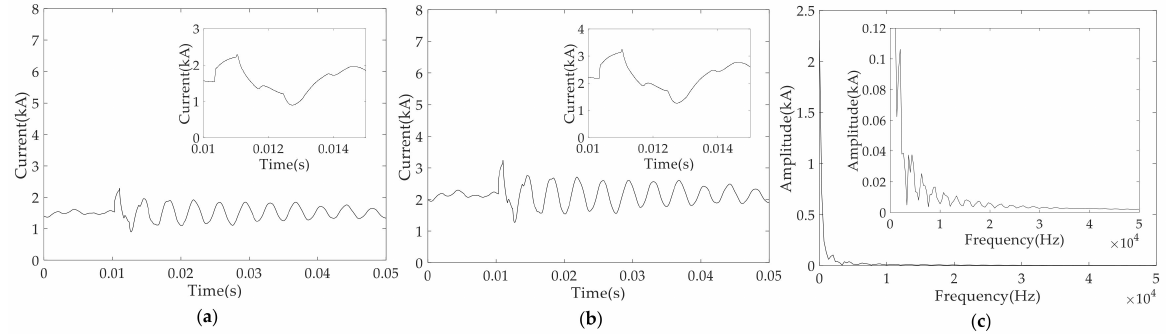
Figure 8. Transient characteristics of a lightning fault (LF). ( a ) Current waveform; ( b ) current line mode component waveform; ( c ) spectrum